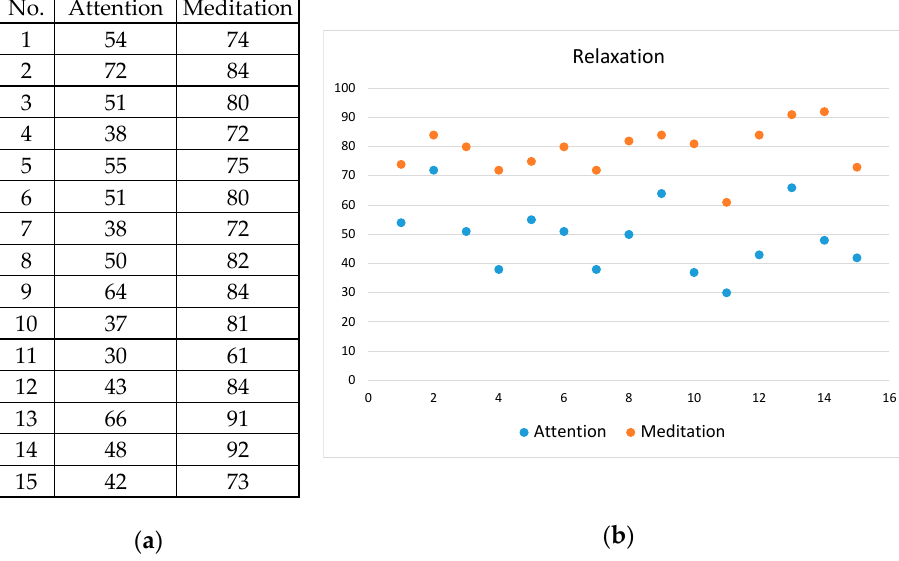
Figure A2. The data and the distribution graph of the average values of the 15 measured two-feature sample sequences of the emotion type of relaxation, from which the corresponding decision rule m ≥ 70 and m > a for emotion classification was inferred, where m and a represent the meditation and attention signals, respectively. ( a ) The average data. ( b ) The distribution graph.